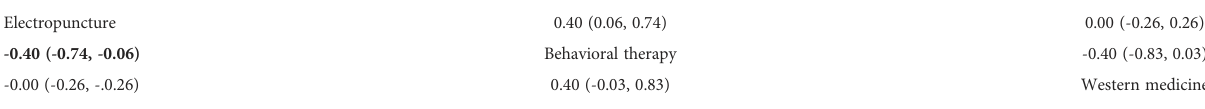
TABLE 12 Network meta-analysis ladder table of total cholesterol.